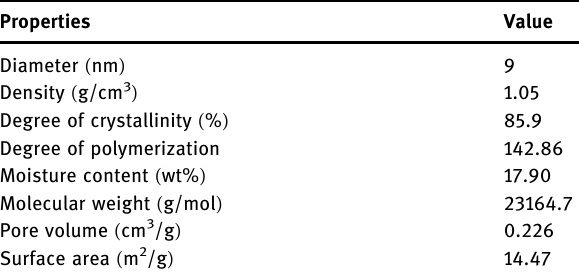
Table 1: Physical properties of SPCNC Properties